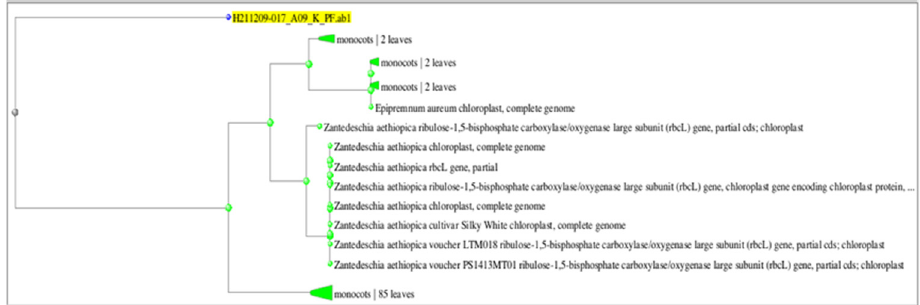
Figure 3. Phylogenetic tree of Zantedeschia albomaculata based on molecular identification.